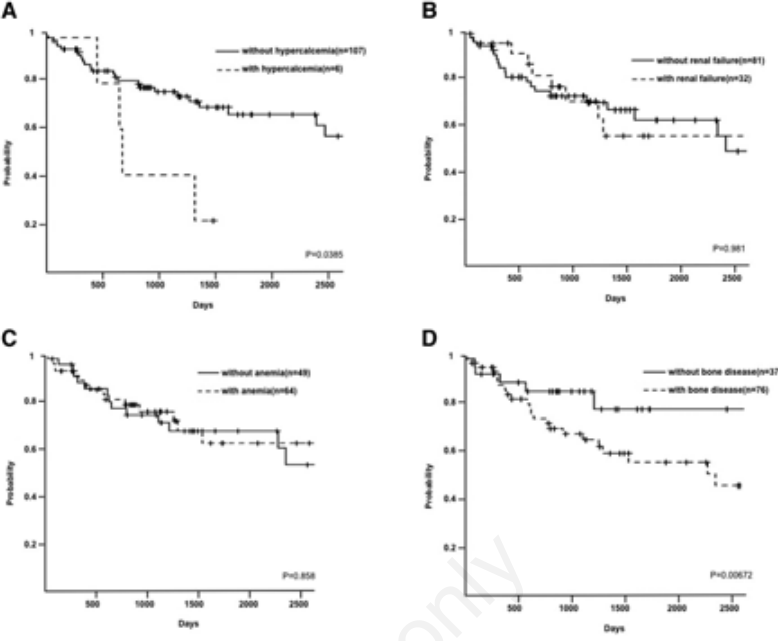
Figure 1. Survival comparison between with CRAB vs . without CRAB factors. A) With hypercalcemia or without hypercalcemia. Median overall survival was 32 months vs. 101 months, respectively (P=0.0385). B) With renal failure or without renal failure. Median overall survival was 101 months vs . 96 months, respectively (P=0.981). C) With anemia or without anemia. Median overall survival was 101 months vs. 96 months, respectively (P=0.858). D) With bone disease or without bone disease. Median overall survival was 80 months vs. data not available, respectively